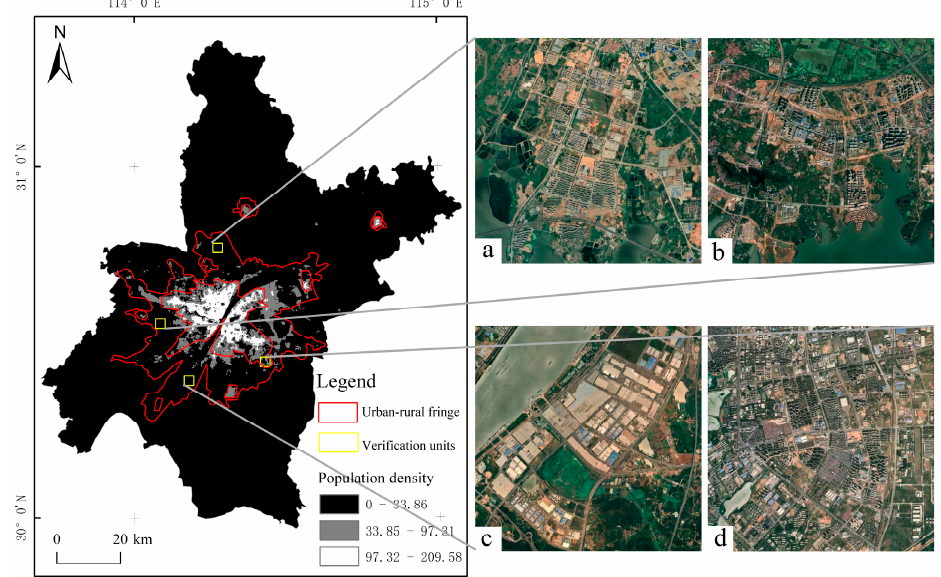
Figure 14. Distribution Map of Boundary and Population Density in the Urban-Rural Fringe of Wu- han City.